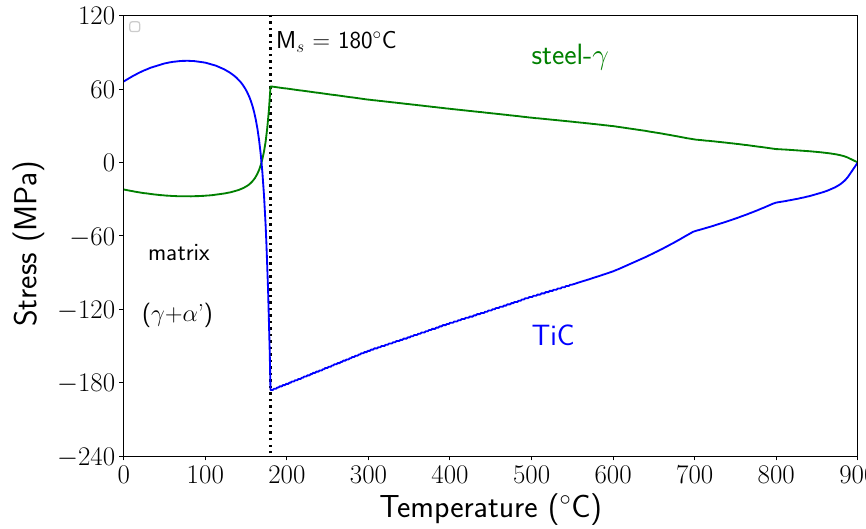
Figure 16. Evolution of the mean calculated stresses in the reinforcements and in the matrix during